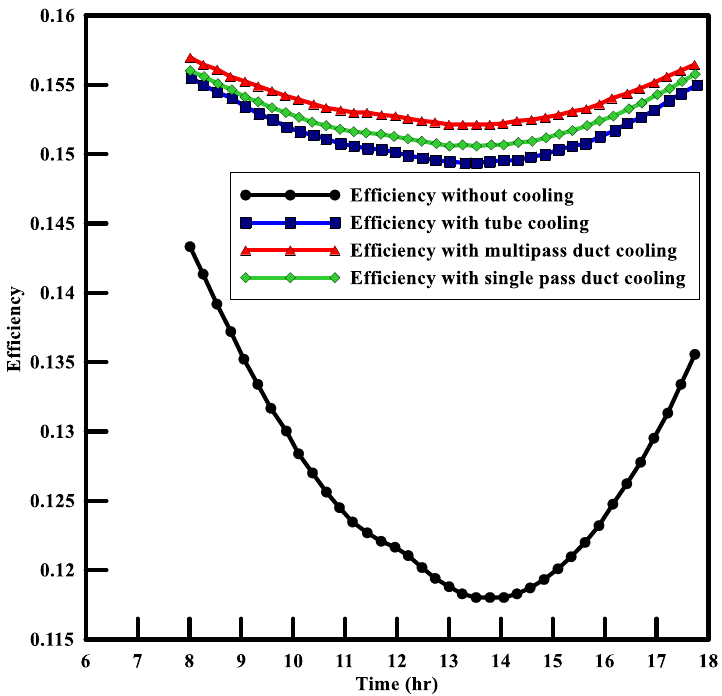
Figure 8. PV efficiency with and without the cooling system for 9th of June.